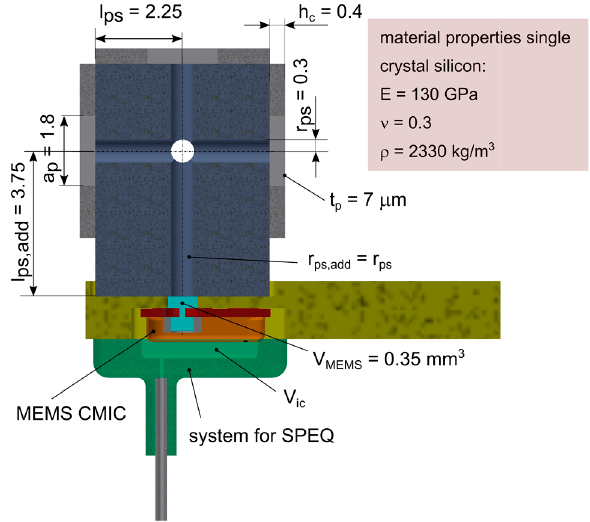
Figure A1. Input parameters in mm of the lumped element model (LEM) characterizing only the protective diaphragm(s) and the corresponding pneumatic tubing system. Input parameters representing the MEMS condenser microphone (MEMS CMIC) are given in Reference [13].